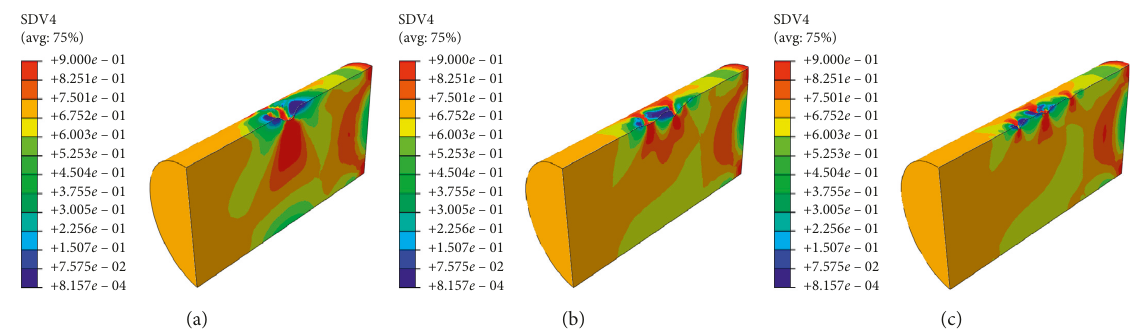
Figure 27: Damage cloud map of steel wires corresponding to the points in Figure 26.